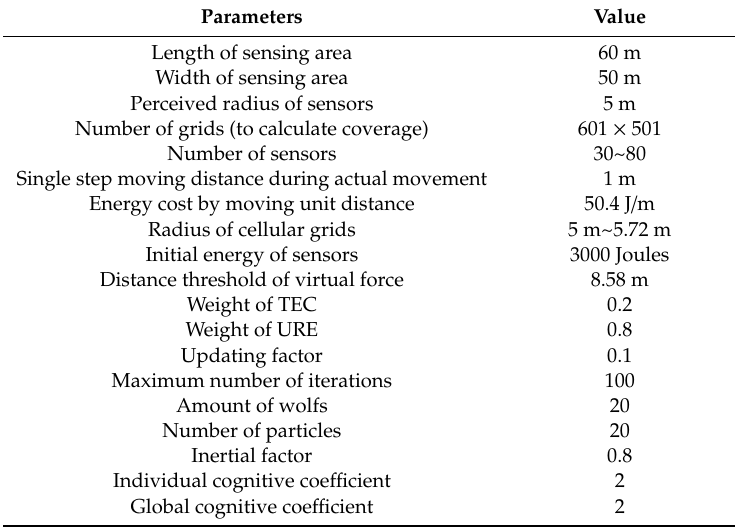
Table 1. Simulation